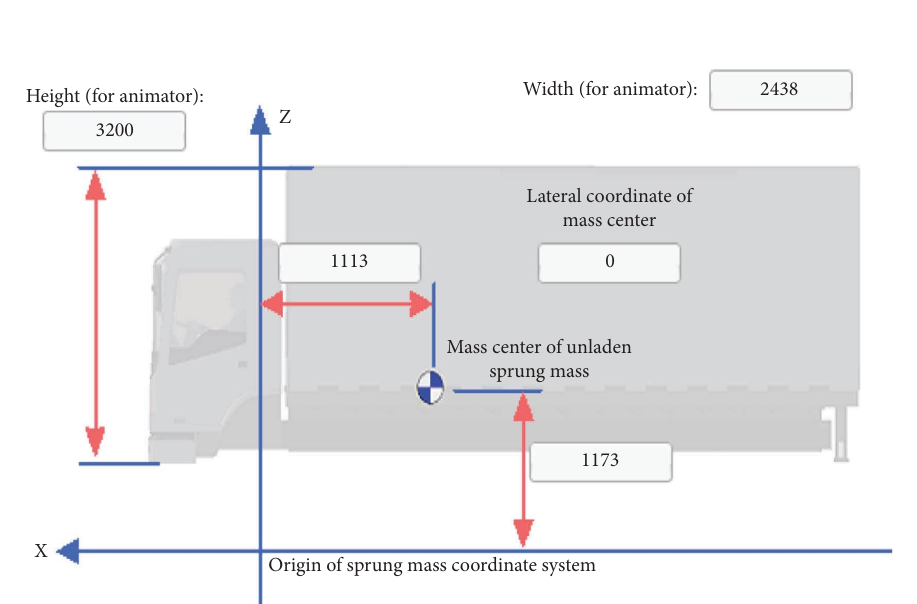
Figure 7: Dimensions and mass of two-axle truck.